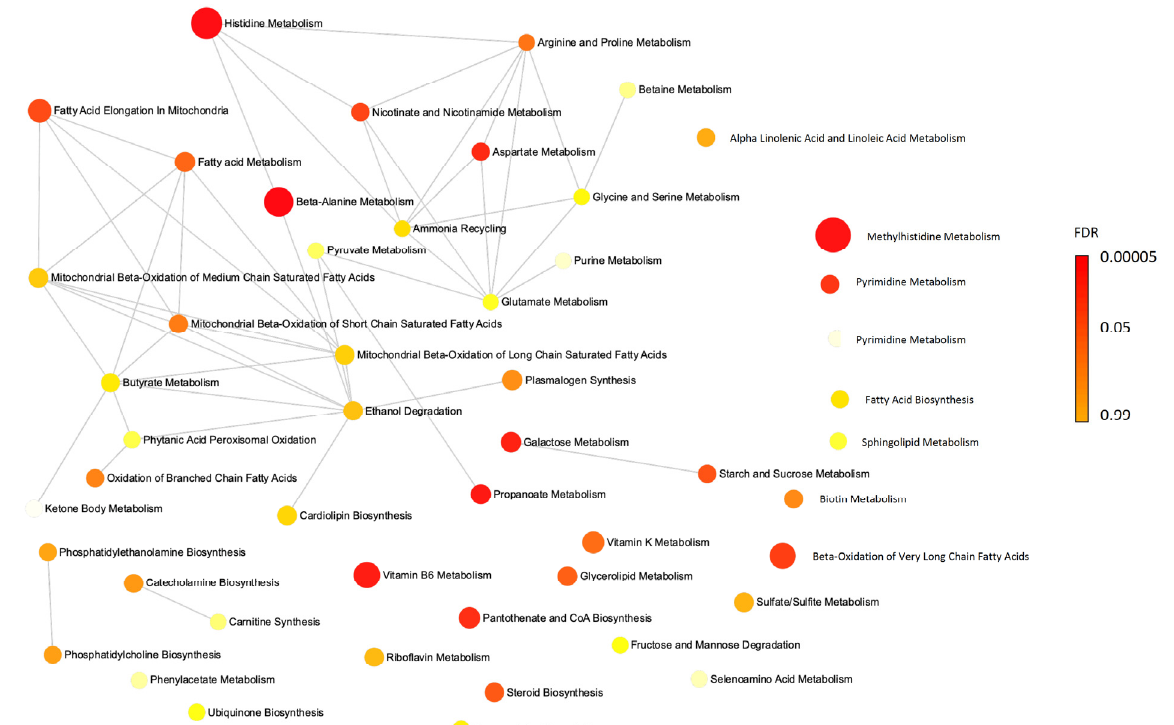
Figure 1. Network analysis for the plasma metabolites. Active pathways adjusted for FDR (<0.05) in participants received animal protein diet, compared to those in soybean protein.